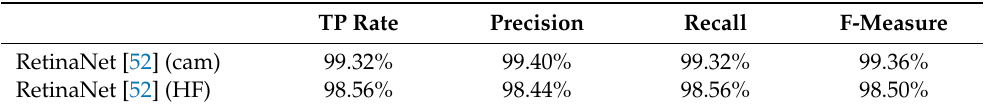
Table 14. The classification TP rate, precision, recall, and F1-score of RetinaNet on camera images (cam) vs. heat frames